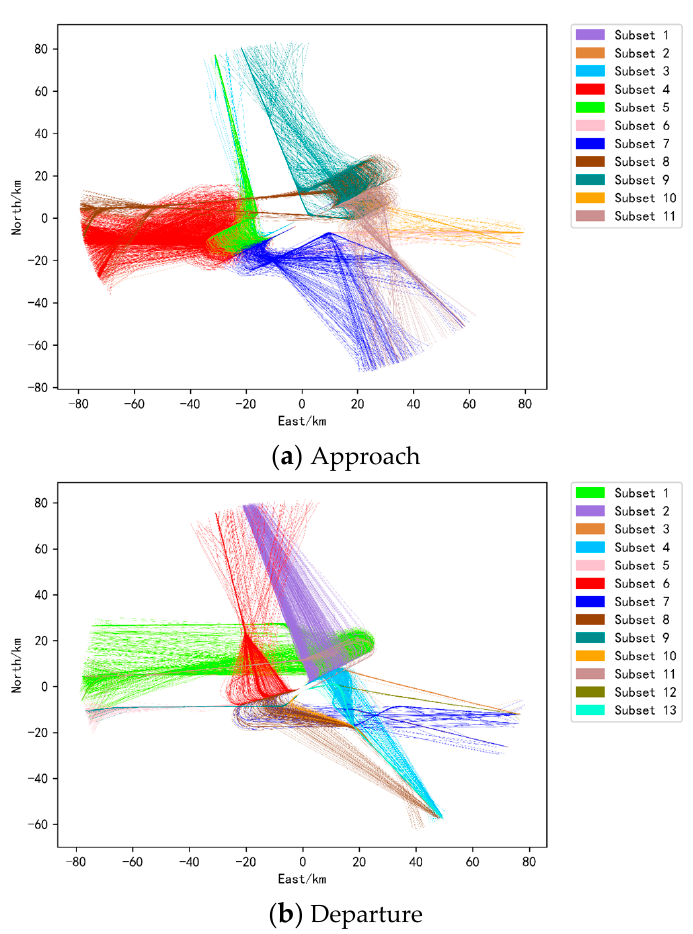
Figure 7. The trajectories after the division of the runway and the corridor. Table 1. Basic information of each sub-dataset.